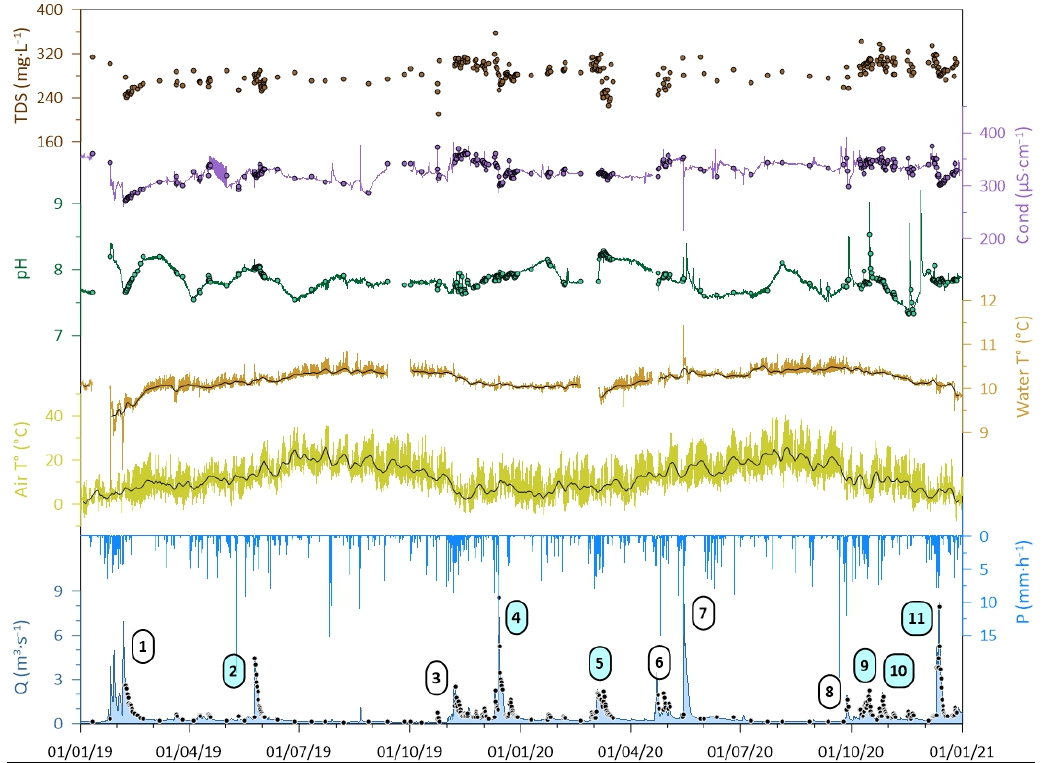
Figure 3. High frequency temporal series of the stream discharge (Q), rainfall (P), and physicochemical parameters (air temperature (air T°), water temperature (water T°), pH, conductivity (Cond), and TDS (total dissolved solids)) during the two years 2019 and 2020. Black solid lines represent the 5-day daily moving average for air and water temperature. Dots represent punctual streamwater sampling during the study period (N = 297). The numbers circled refer to the major floods sampled during the study period. Flood events 2, 4, 5, 9, 10, and 11 (light blue circles) were considered further as typical examples.